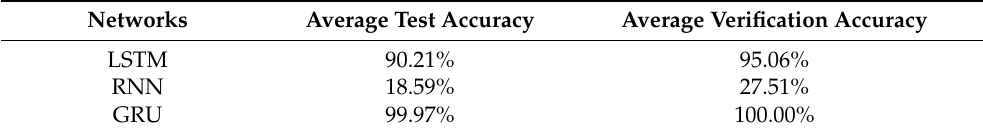
Table 9. The results of five rounds of crossover experiments with different